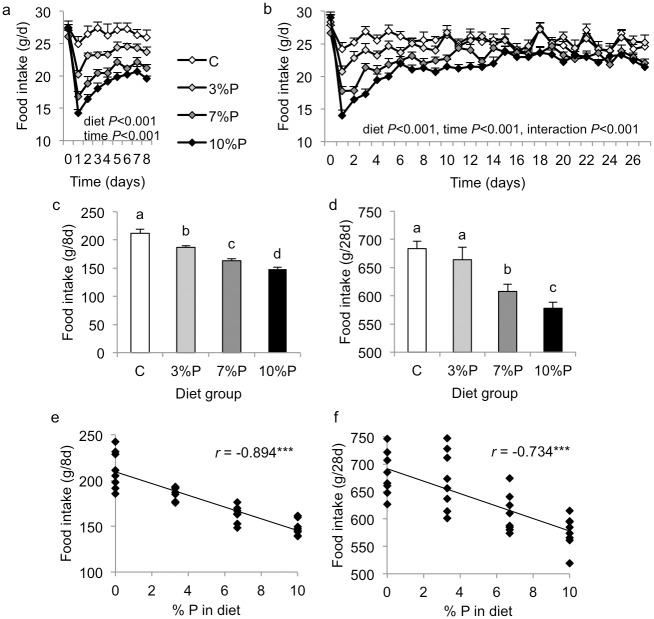
Food intake.Daily (a, b) and cumulative (c, d) voluntary food intake by rats offered control diet (C) or diet containing 3, 7 or 10% pectin (P) for 8 days (a, c) or 28 days (b, d), and correlation between cumulative intake and amount of P in the diet in 8-day (e) and 28-day (f) cohorts. Results of repeated measures ANOVA are indicated in figures a and b. Columns labelled with different letters in figures c and d are significantly different by one-way ANOVA, P<0.05, and r is the Pearson product-moment correlation coefficient in figs e and f, ***P<0.001.